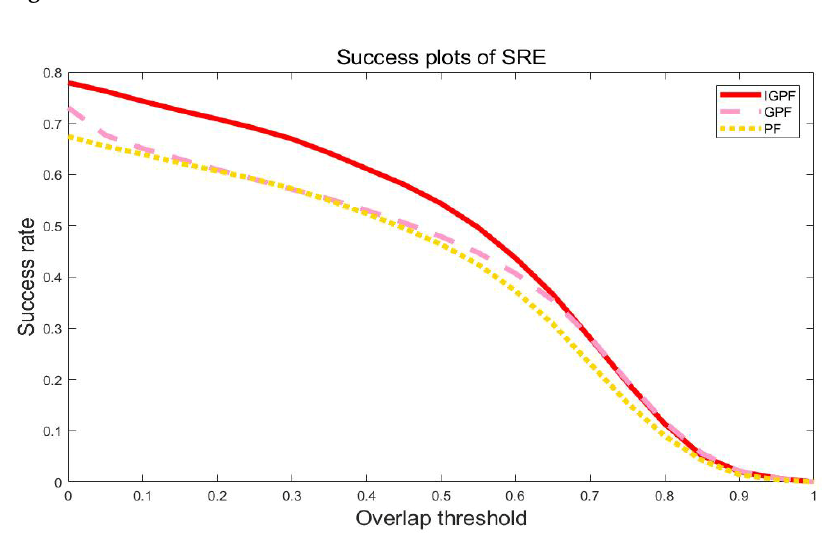
Figure 8. OS SRE Figure 8. OS SRE curve. Figure 8. OS SRE curve.